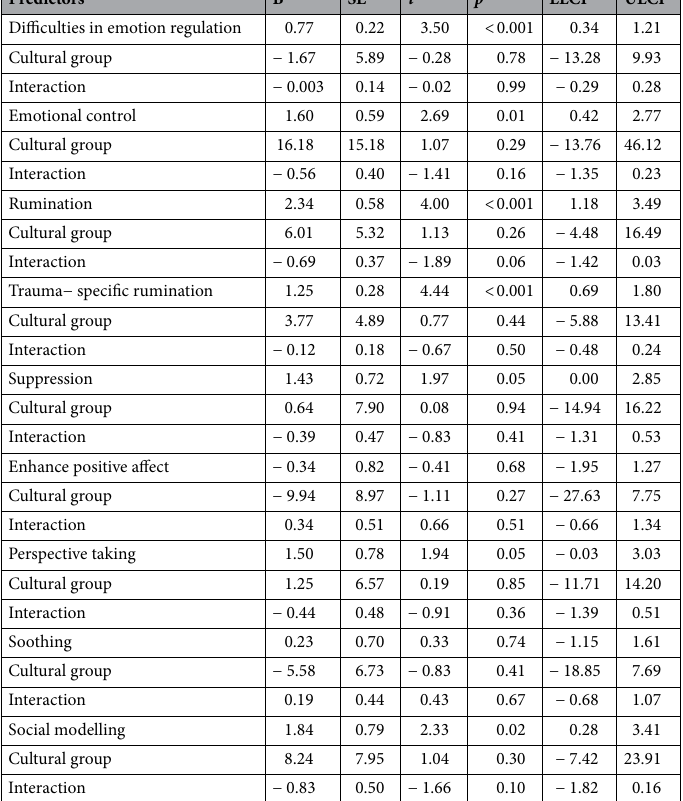
Table 3. Summary of regression analyses for emotion regulation analyses with posttraumatic stress disorder symptoms as the outcome variable. LLCI, lower level confidence interval; ULCI, upper level confidence